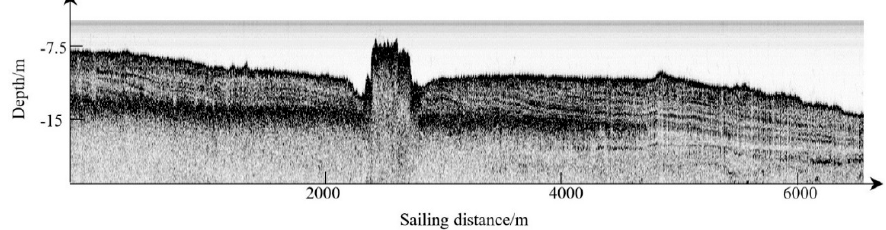
Figure 2. The built SBP image using appropriate parameters.